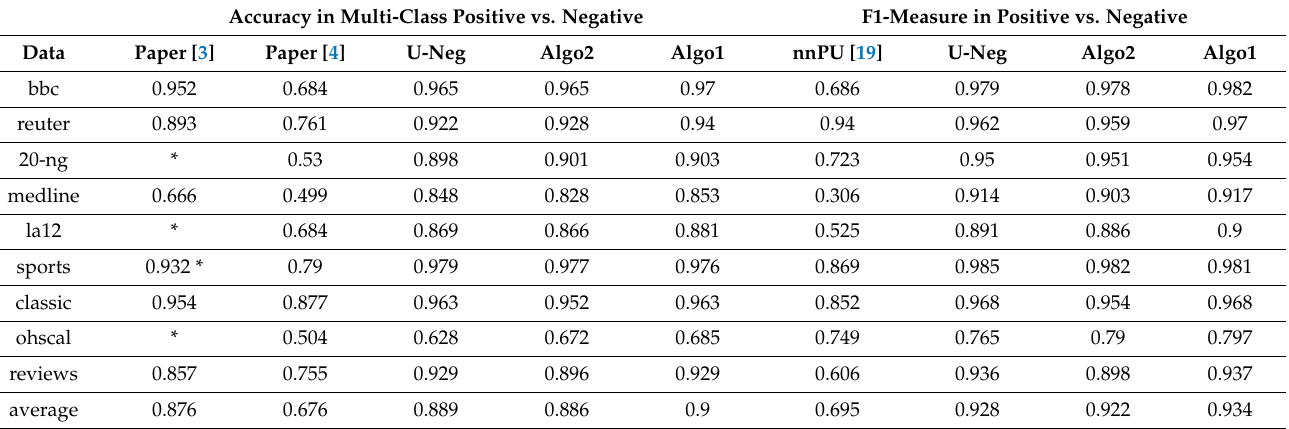
Table 4. Performance comparison by accuracy and F1-measure when 80% of data samples randomly selected from each class constitute unlabeled negative data.